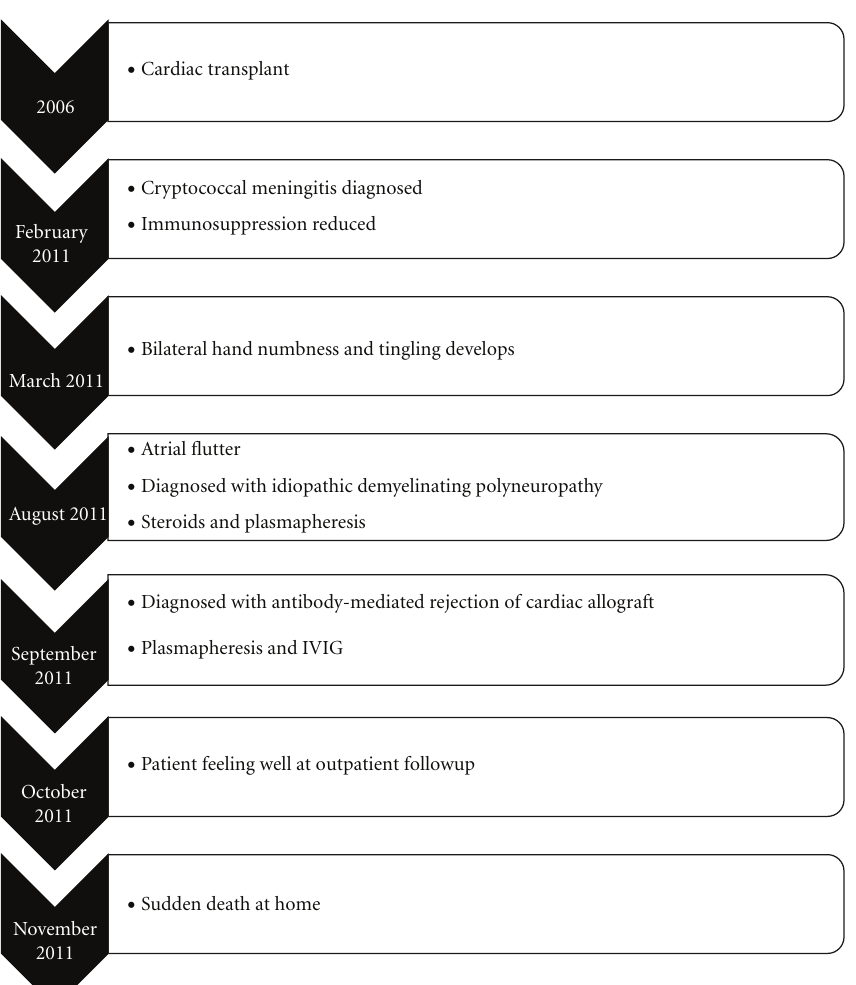
Figure 3: Timeline of